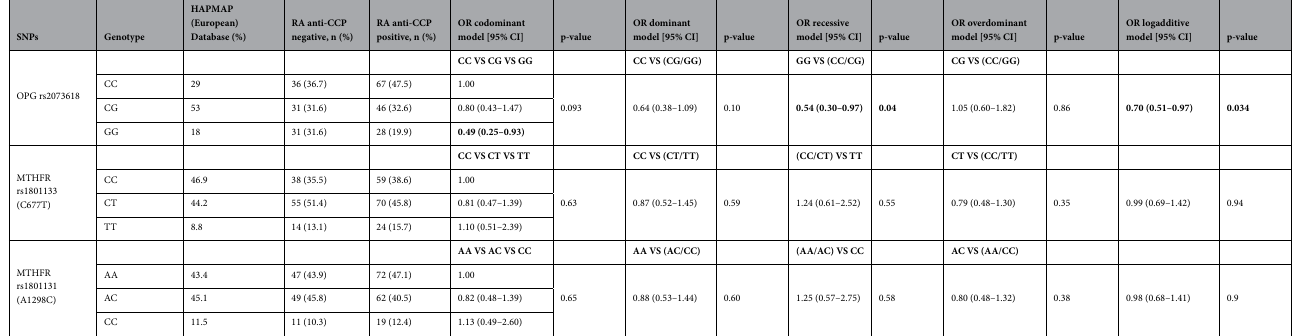
carotid/femoral plaque formation (52.4 vs 72.7, p-value: 0.009, respectively, Table 2). This association remained